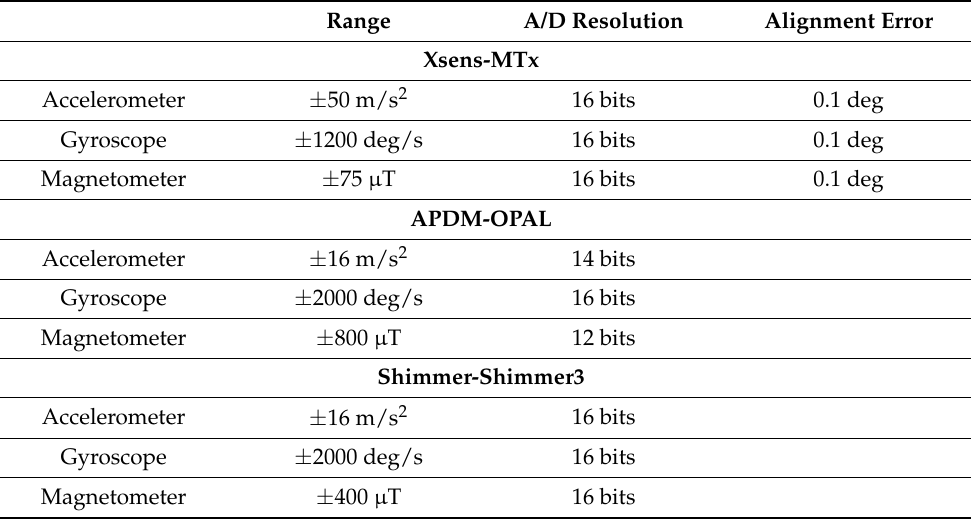
Table A5. Sensor Specifications. Reprinted with permission from ref. [31]. Copyright 2020 IEEE.